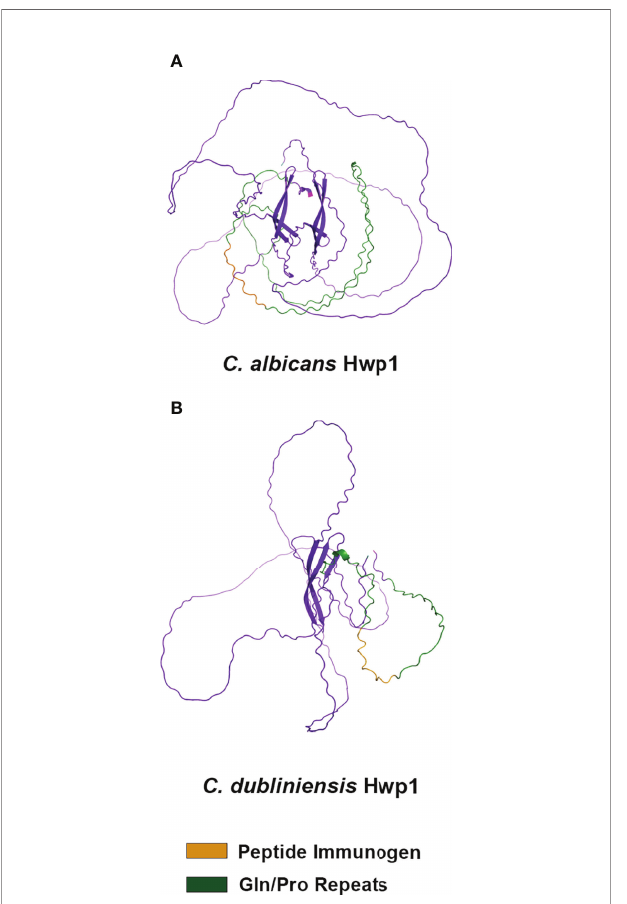
FIGURE 4 | Alpha Fold structural prediction for C. albicans Hwp1 and its C. dubliniensis ortholog. The C. albicans Hwp1 structural prediction (A) was downloaded from the Alpha Fold Protein Database [P46593 (HWP1_CANAL)]; AlphaFold Colab was used to generate the structural prediction for C. dubliniensis Hwp1 (GenBank XP_002419994; (B) . Amino acid sequences were trimmed to re fl ect cleavage of the secretory signal peptide, as well as processing of the Kex2 and GPI anchor addition sites. AlphaFold predicted a largely unstructured molecule for each but had low con fi dence in the predictions except for the region of antiparallel beta- sheets in the C-terminal half of the protein. The Gln-Pro-rich repeated sequences (green color) were more extensive in C. albicans Hwp1 than in the C. dubliniensis protein. Orange color denoted the immunogen used to raise anti-Hwp1 MAb 2-E8, for which 10 of 13 amino acids were conserved in the C. dubliniensis protein ( Table 2 ).